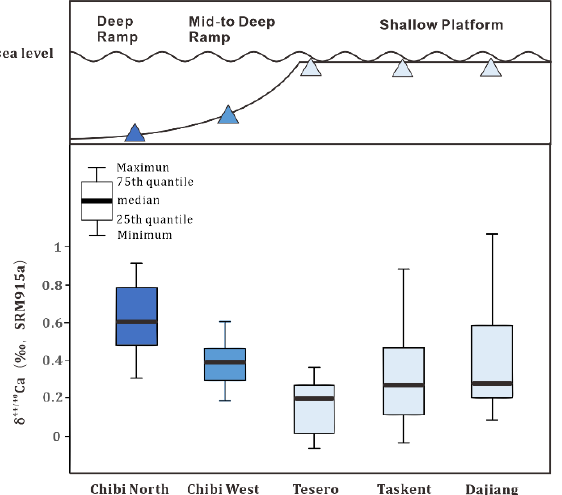
Figure 5. Calcium isotope data at different water depths during the Permian-Triassic. The colorful triangles represent the carbonate section. Chibi North and Chibi West sections data are from this study.Tesero, Taskent data are from [5], Dajiang section data are from [14].